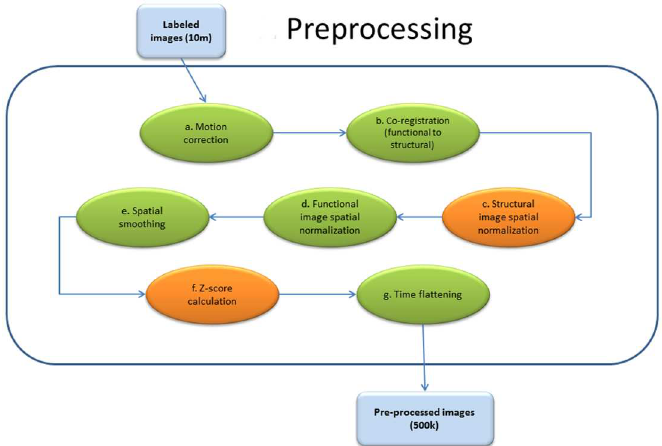
Fig 2. Preprocessing pipeline. The preprocessing pipelinefor functionaland structural magneticresonance images is summarized in the figure. Orange shapes in the image show the steps of preprocessing necessary for both fMRI and structural MRI scans. Green shapes show the preprocessing steps only neededfor fMRI scans. This figure is best viewedin color.